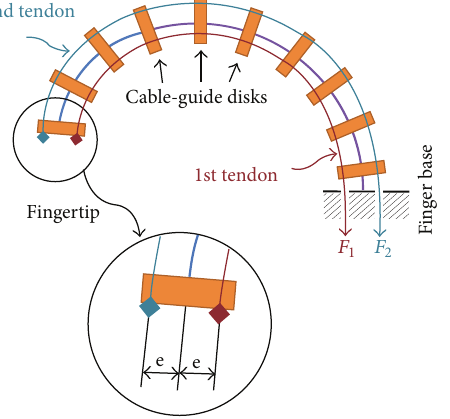
Figure 7: A tendon driven actuation system.